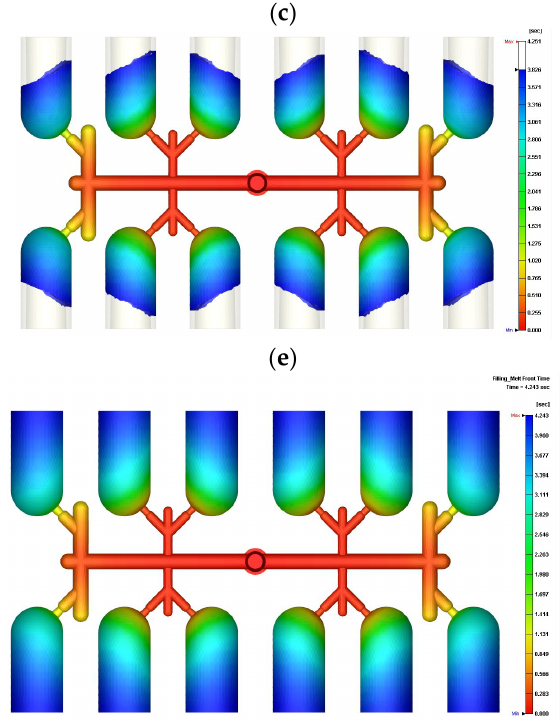
Figure 5. Flow fronts of different filling percentages under optimization of the injection rate to achieve balanced filling of a multi-cavity mold: ( a ) 50% filling; ( b ) 70% filling; ( c ) 90% filling; ( d ) 97% filling; ( e ) time delay 0.008 s.